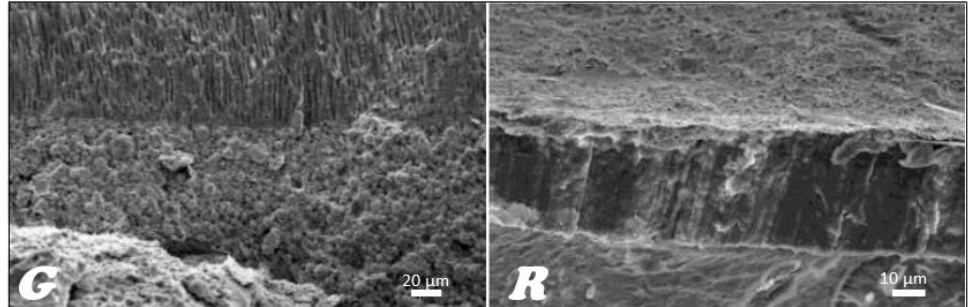
Figure 21. Tight connection of filling material covered with an intermediate layer of sealant and root canal dentin after hot thermoplastic obturation using the THC technique: ( G ) gutta-percha-based filling material; ( R ) resilon; SEM.